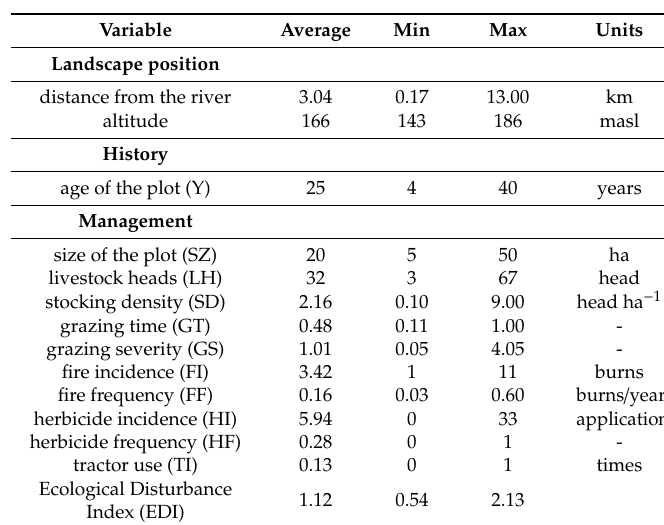
Table 1. Landscape, history of use, and management variables tested in the model, their average, and maximum and minimum values for 31 study